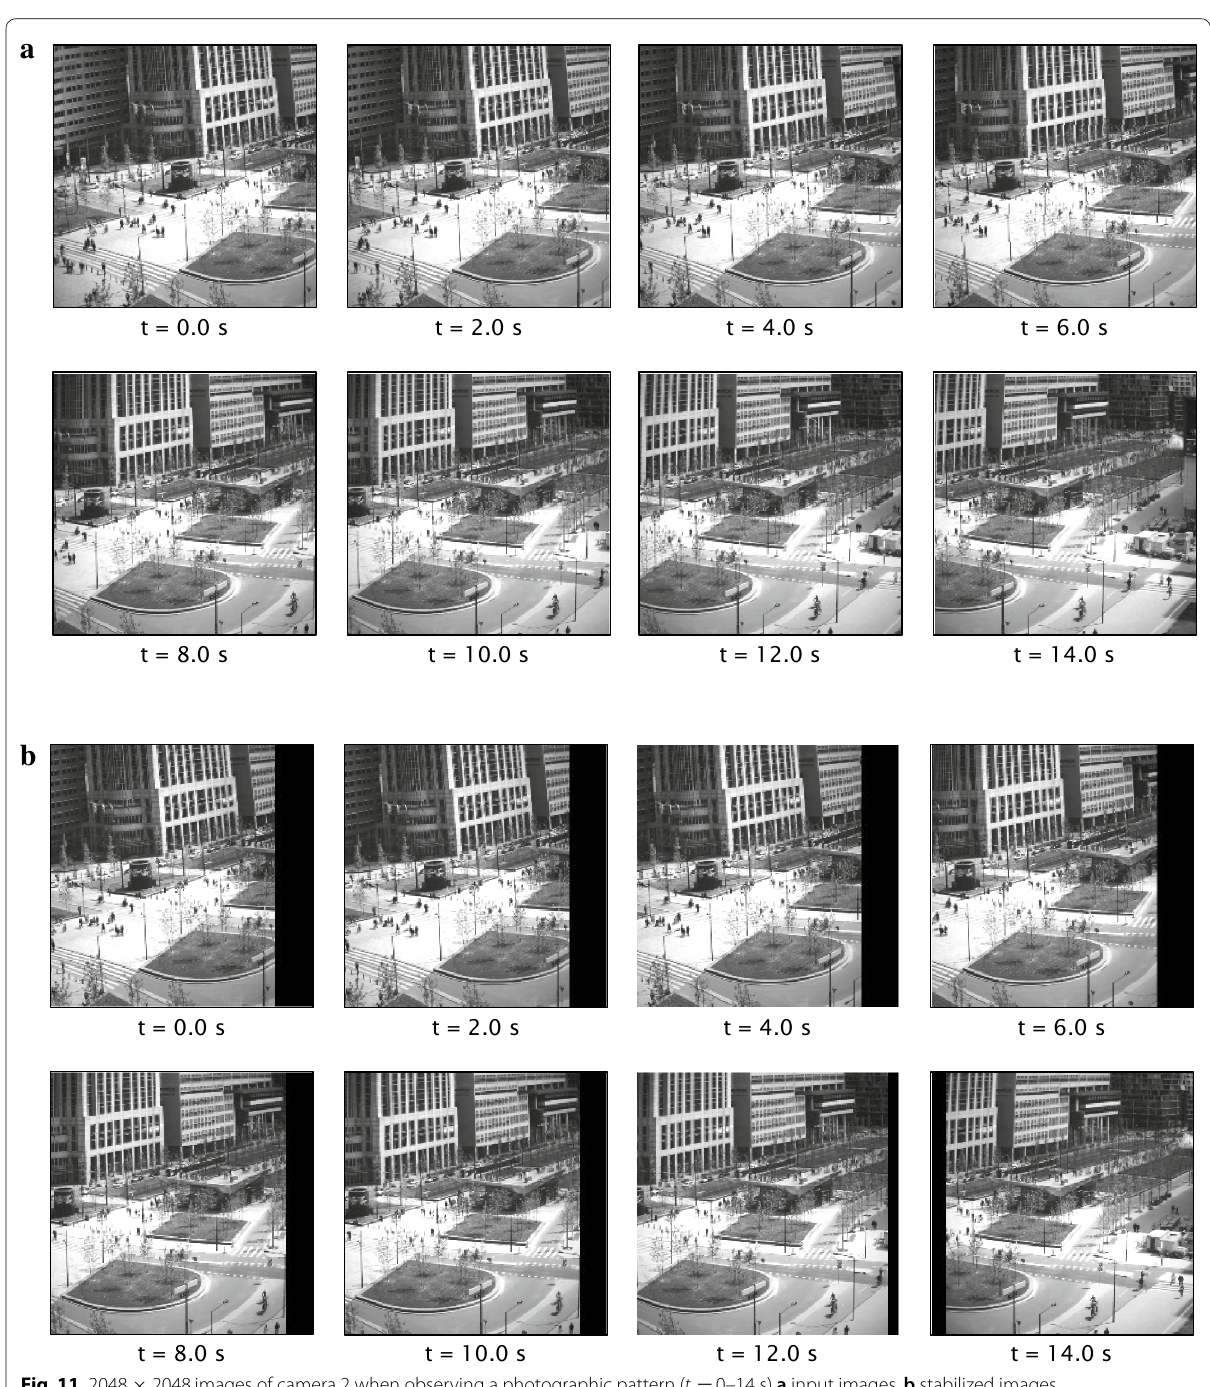
Fig. 11 2048 × 2048 images of camera 2 when observing a photographic pattern ( t = 0–14 s) a input images, b stabilized